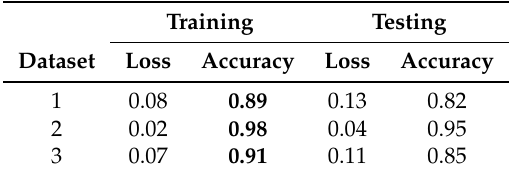
Table 11. Performance of Model [5] on lexical